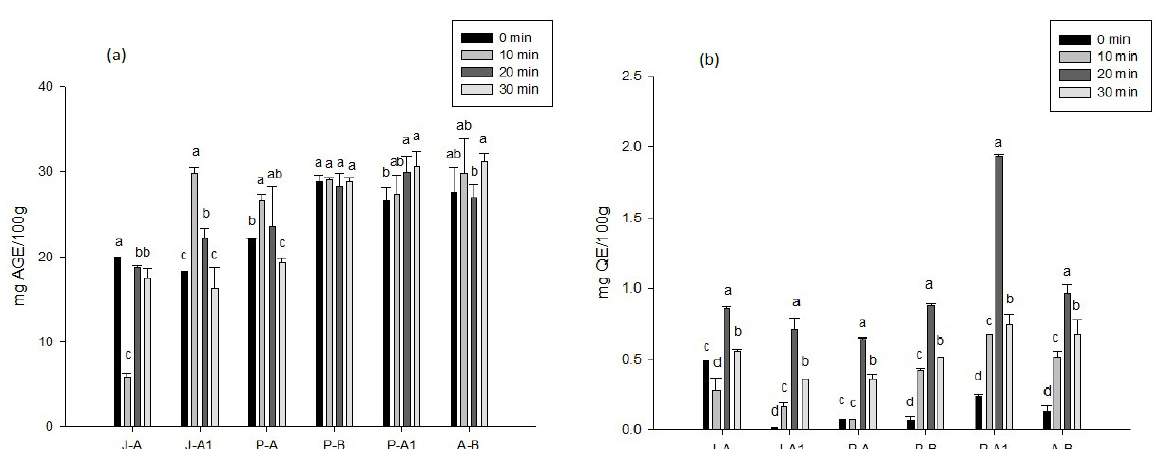
Figure 1. Effects of different ultrasound times (0, 10, 20, 30 min) on the bioactive compounds of different honeys: ( a ) total phenols and ( b ) total flavonoids. The results are expressed as means ± standard deviation. Different letters represent significant differences ( p < 0.05) between treatments. The six types of pollen with the highest frequency in appearance are presented; in general, these grains represent more than 50% of the total pollen quantified.